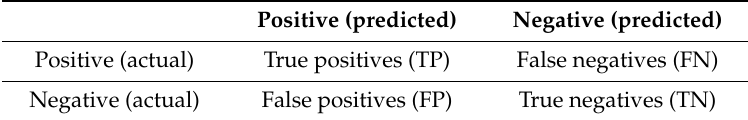
Table 3. Confusion matrix charted by the predicted and actual